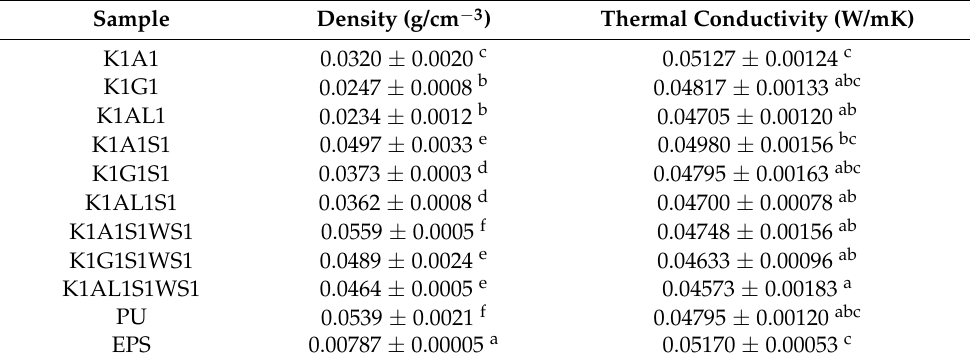
Table 1. Density and thermal conductivity of KGM-based aerogels, PU, and EPS. Sample